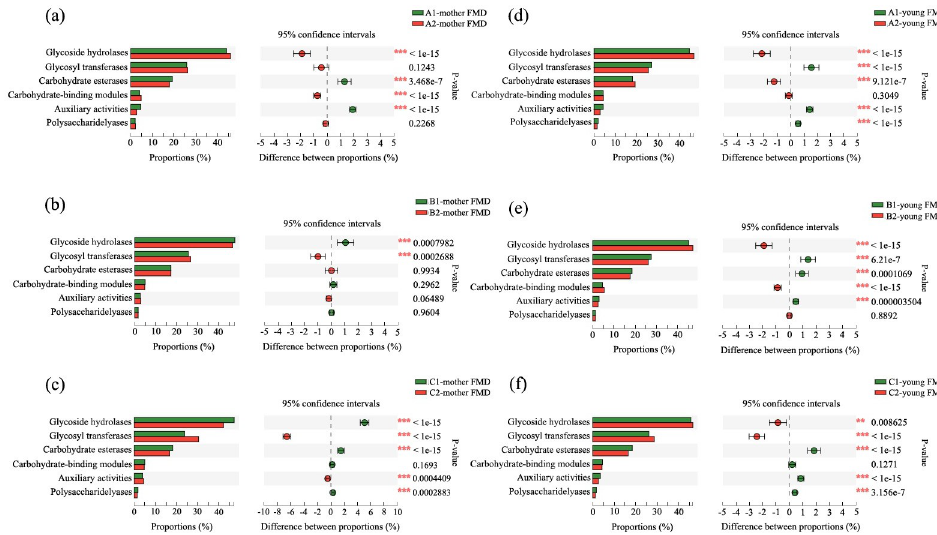
Fig 4. Comparison of functional differences before and after separation of female (a-c) and infant FMD (d-f) based on the CAZy database at different separation times (a, d: 80 days; b, e: 90 days; c, f: 100 days).